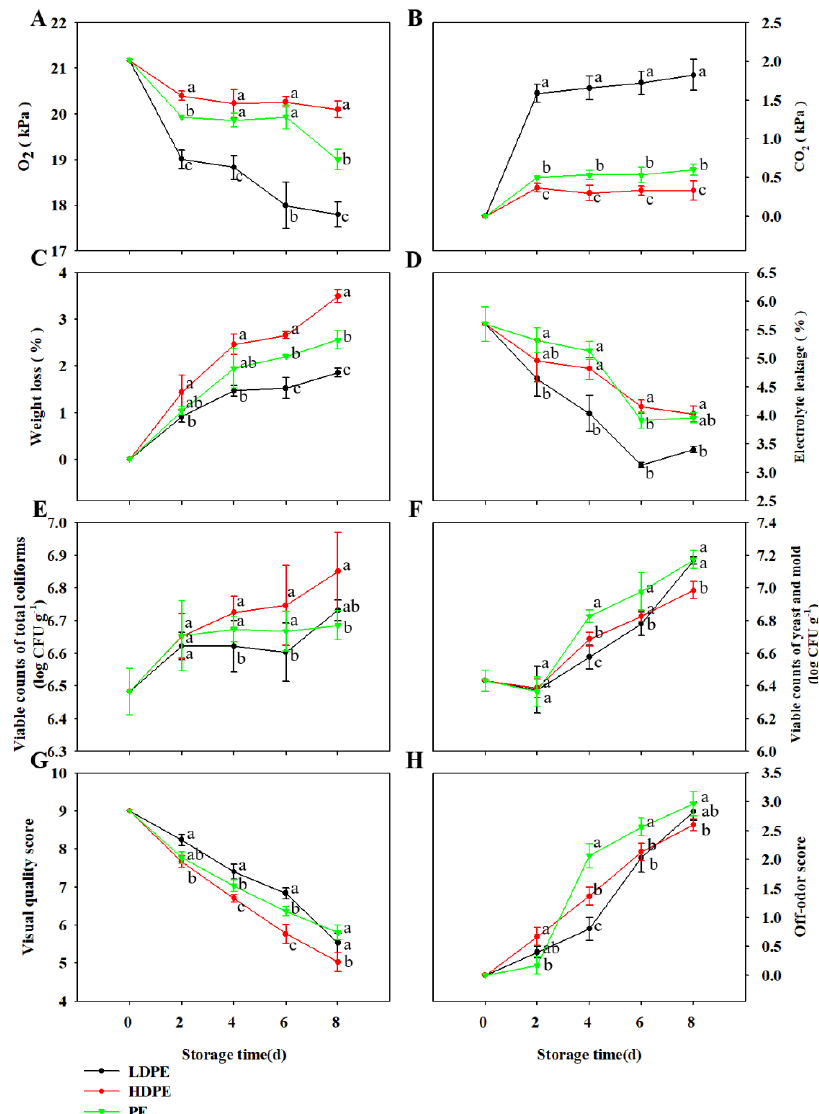
Figure 2. Effect of packaging material on the changes in O 2 ( A ) and CO 2 ( B ) partial pressures within packages, weight loss ( C ), electrolyte leakage ( D ), counts of total coliforms ( E ) and yeast and mold (Y&M) ( F ), overall quality score ( G ) and off-odor score ( H ) of TBM during 5 ◦ C storage. The vertical bar represents ± standard error. Significant differences between samples (within the same time point) are indicated with different lowercase letters above the